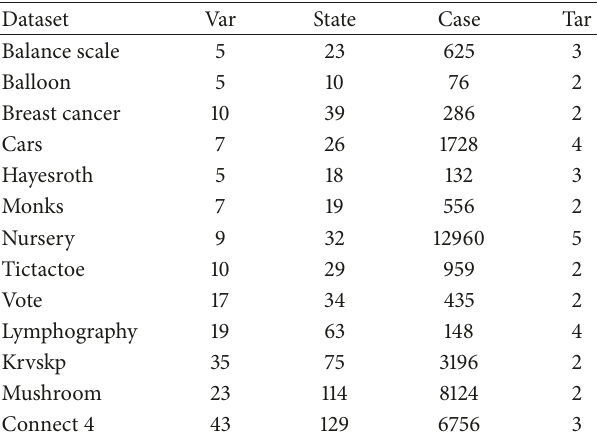
Table 6: UCI benchmarks characteristics